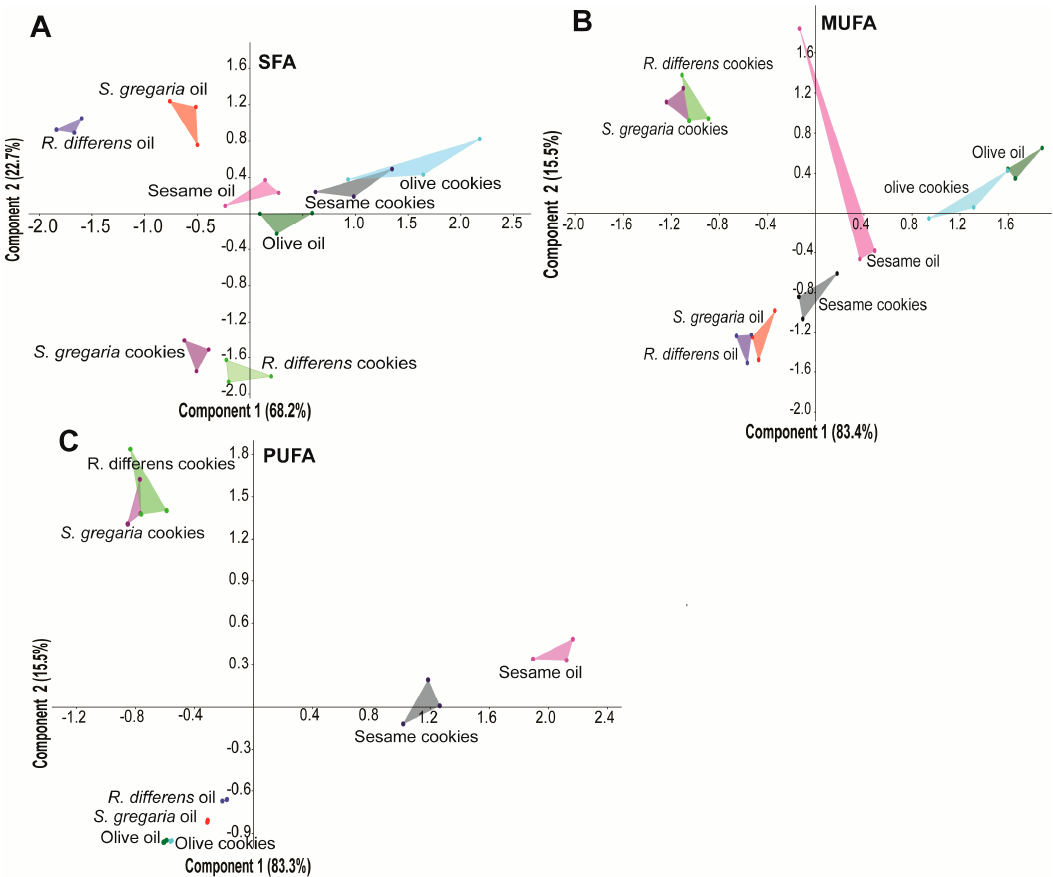
Figure 4. Principal component analysis (PCA) biplots showing the variation of ( A ) saturated fatty acid (SFA), ( B ) monounsaturated fatty acid (MUFA), and ( C ) polyunsaturated fatty acid (PUFA) among the different oil categories and cookies type.